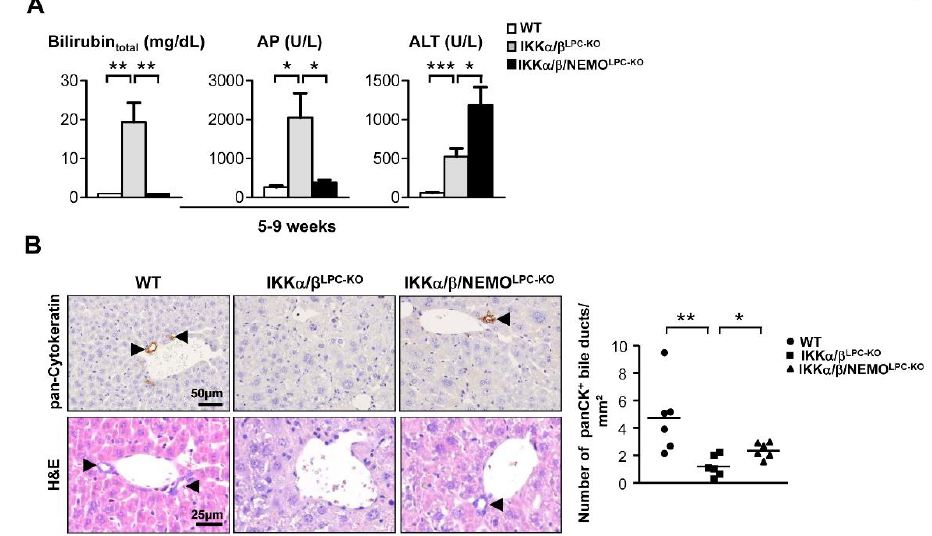
Figure 2. Loss of Nemo expression rescues the cholestasis phenotype of IKK / LPC-KO ( A ) Serum level analysis of total bilirubin, alkaline phosphatase (AP) and serum alanine aminotransferase (ALT) in male mice. * p < 0.05; ** p < 0.01; *** p < 0.001 (n = 5). Results are shown as mean, error bars indicate SEM. ( B ) Immunohistochemistry and quantification for pan-Cytokeratin and Haematoxylin and eosin staining (H&E) of liver paraffin sections. * p < 0.05; ** p < 0.01 (n = 6).